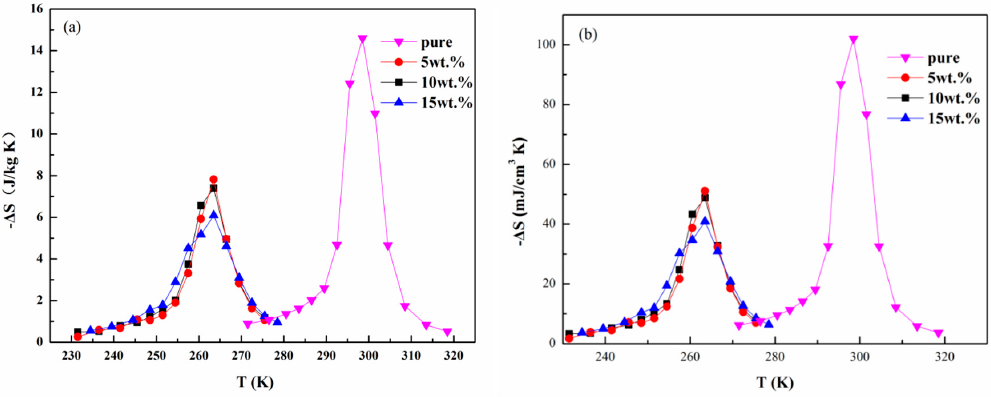
Figure 5. ( a ) Temperature dependence of mass Δ S M for LaFe 11.6 Si 1.4 H 1.4 and LaFe 11.6 Si 1.4 H y /Bi composites with different metallic Bi contents under a magnetic field change of 2 T; ( b ) Temperature dependences of volumetric Δ S M for LaFe 11.6 Si 1.4 H 1.4 and LaFe 11.6 Si 1.4 H y /Bi composites with different metallic Bi contents under a magnetic field change of 2 T.